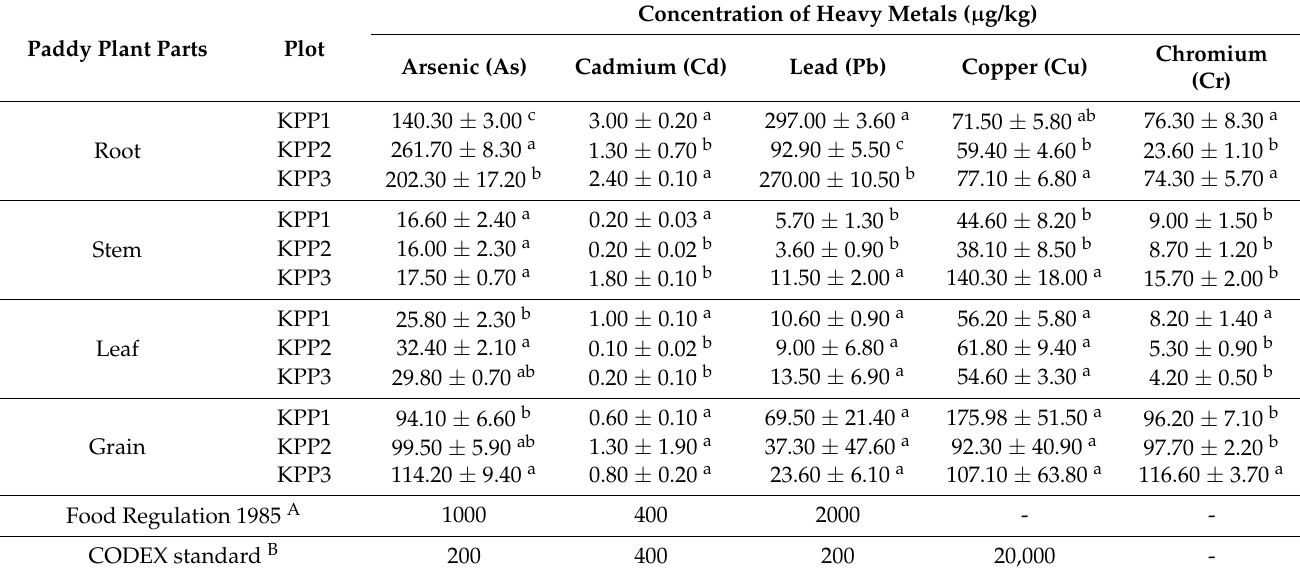
Table 3. Concentration of heavy metals in paddy plant parts from the Kubang Pasu area.